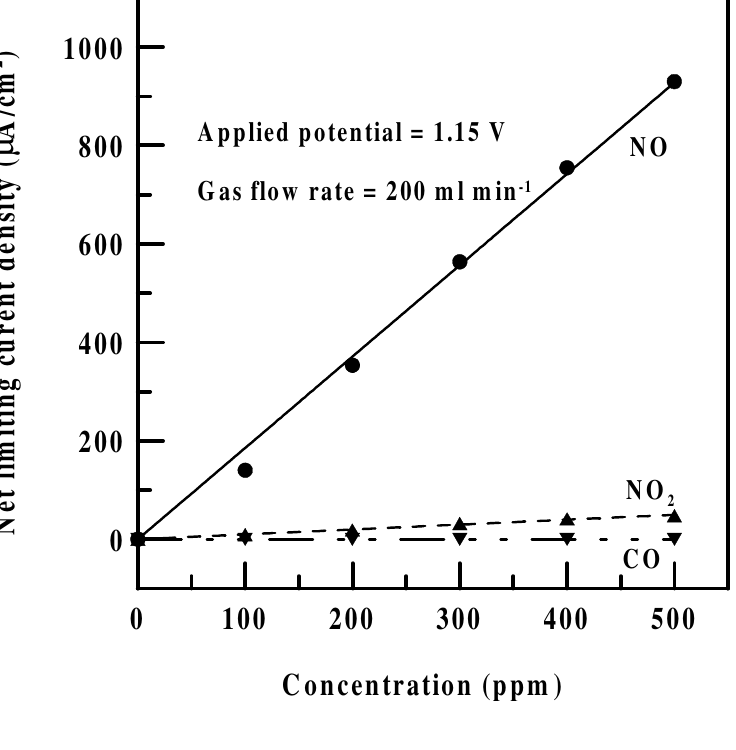
, and CO concentrations (0-500 2